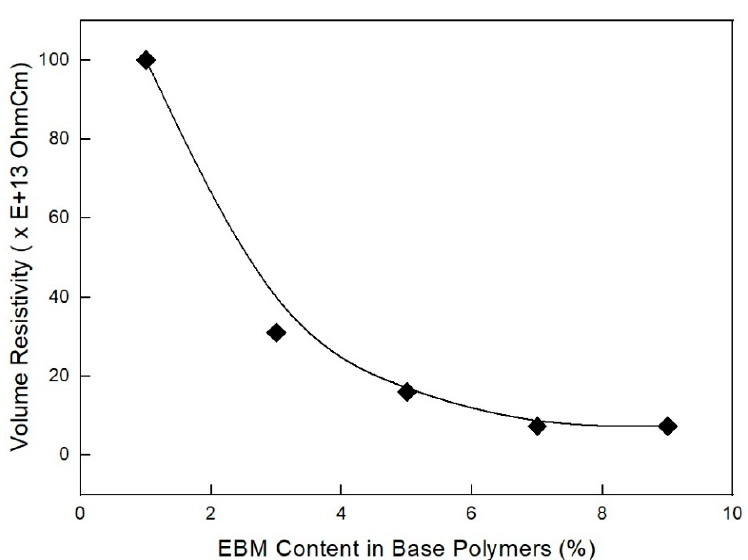
Figure 17. Volume resistivity ( Ω cm) of EVA/EXACT 8201/CLNA-8400/. 125 phr flame-retardant Figure 17. Volume resistivity ( Ω cm) of EVA/EXACT 8201/CLNA ‐ 8400/. 125 phr flame ‐ retardant (MH+ZB+RP) formulations as a function of EBM content. (MH+ZB+RP) formulations as a function of EBM